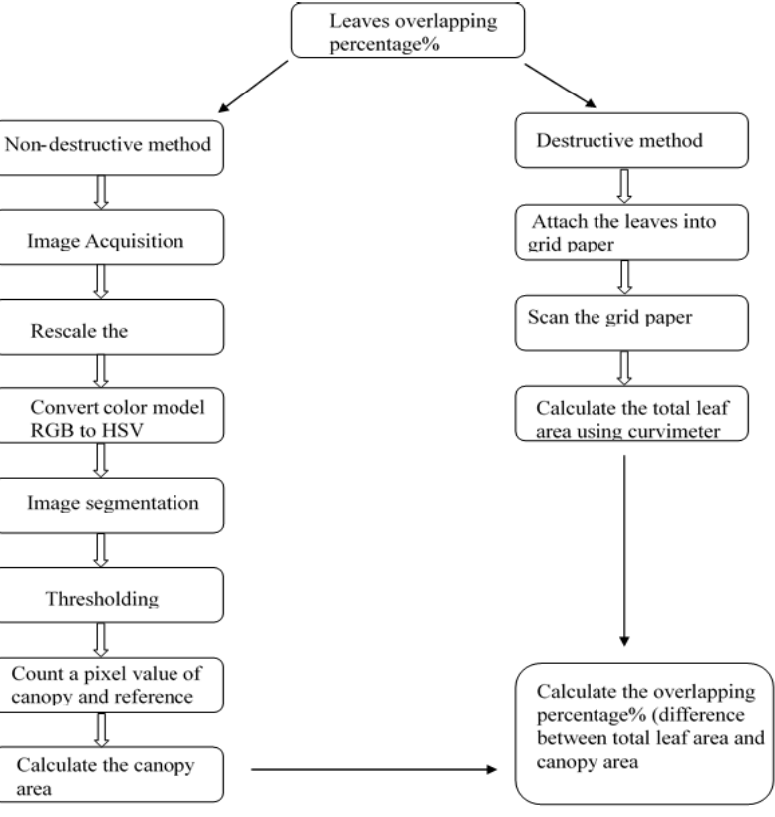
Figure 2. The flowchart of the measurement of overlapping percentage (%) of ice plant leaves.